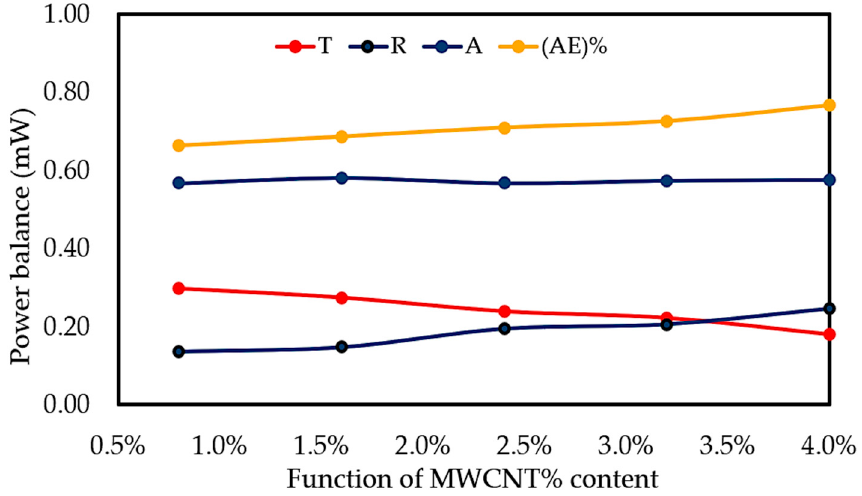
Figure 13. Power balance in the X-band frequency range for 3 mm plates made of MWCNT / PLA / PEG nanocomposites as a function of MWCNTs filler content.